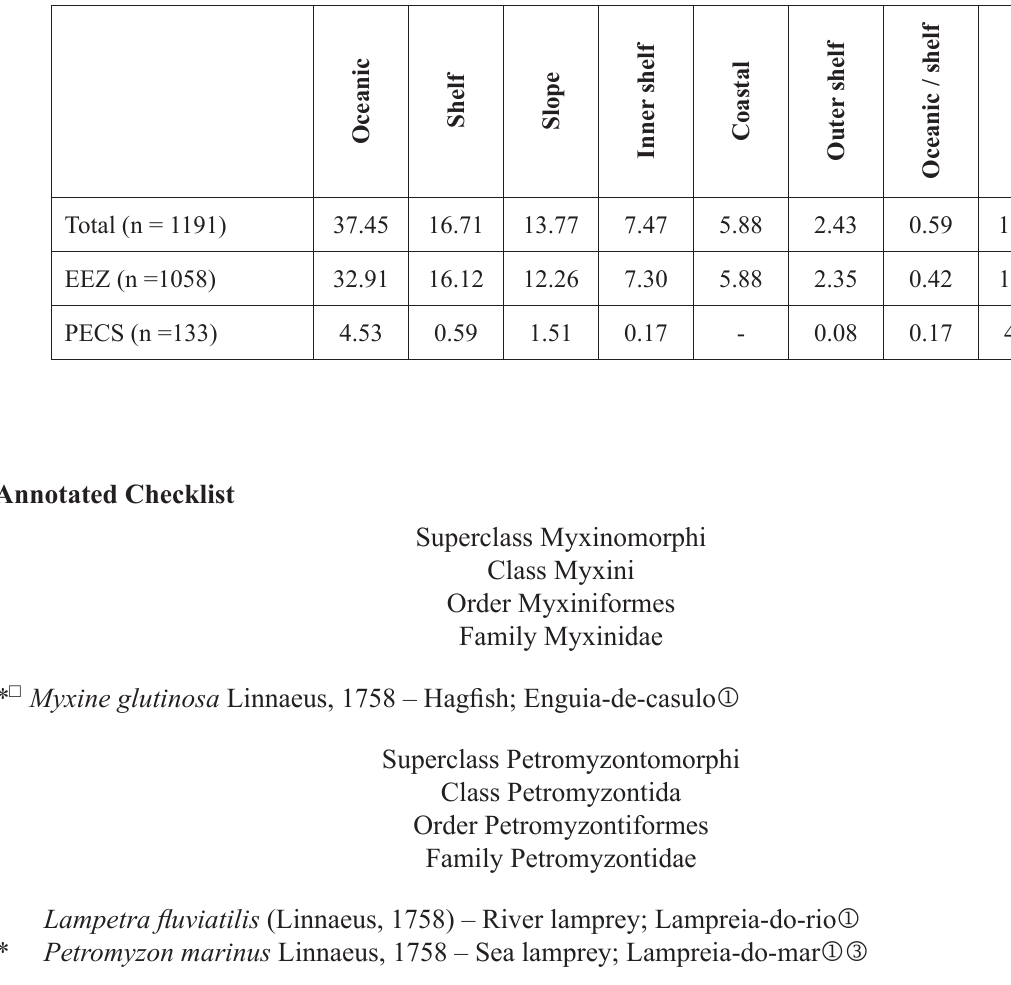
Table 6. Proportion of fish species by preferred horizontal habitat, distributed by the total study area, EEZ plus territorial waters, and the area corresponding to the proposed extension of the Portuguese continental shelf